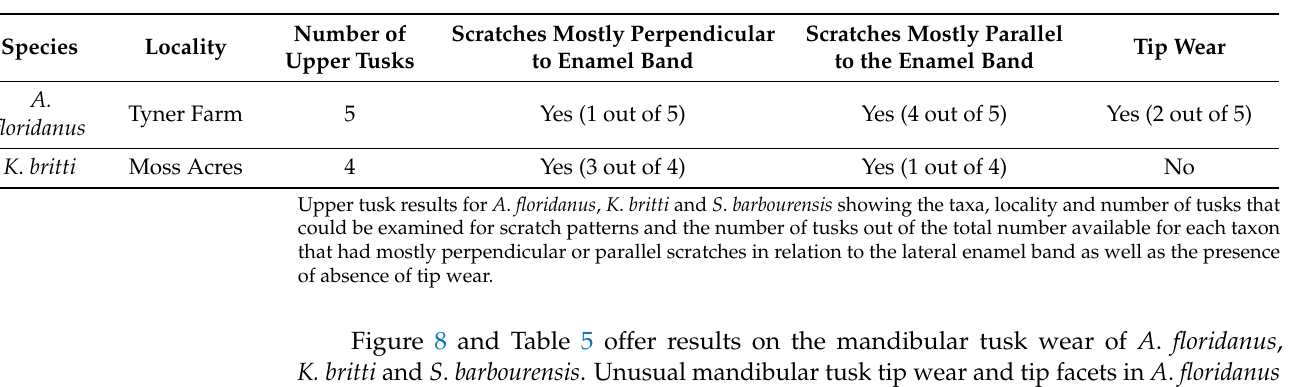
Table 4. Upper tusk results for A . floridanus , K . britti and S . barbourensis .